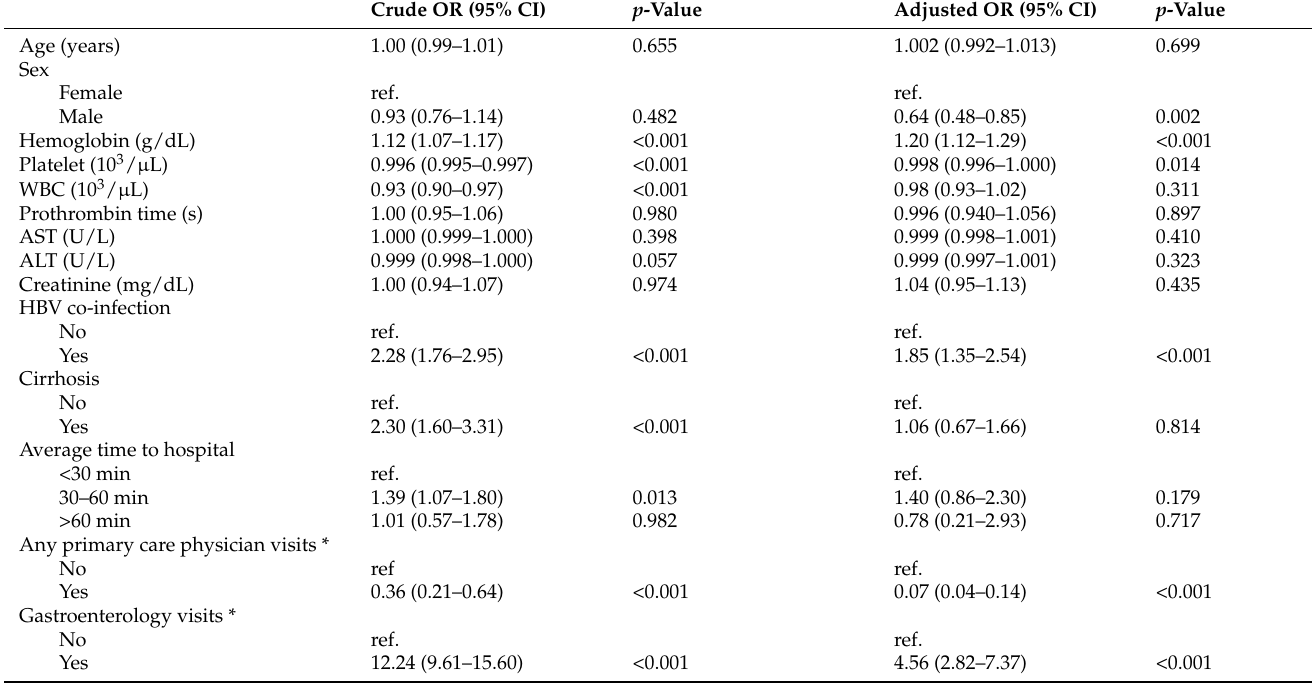
Table 2. Crude and adjusted odds ratios of HCV patients who received DAA treatment or